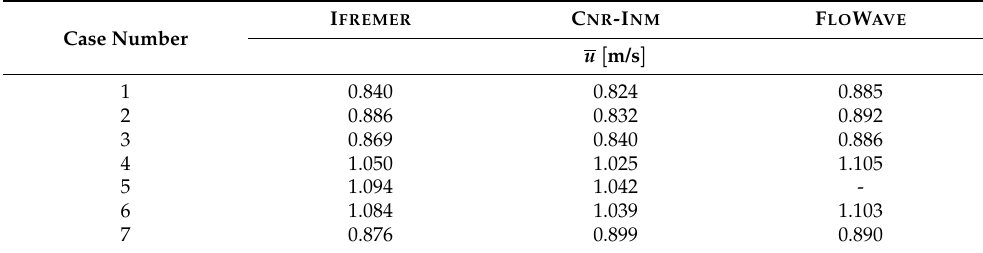
Figure 8. Time average (markers) and standard deviation (shading) of the ADV stream-wise velocity u measured in synchronisation with the turbine against turbine rotational speed for wave and current case 2 at all facilities. Dashed lines are the average of u for case 2 at all rotational speed settings per facility. Red line is the target value of 0.8 m/s. Table 6. Time and case average of the ADV stream-wise velocity u for all cases at all facilities. ADV mounted at x ADV = 0 and y ADV = 1200 mm as seen in Figure